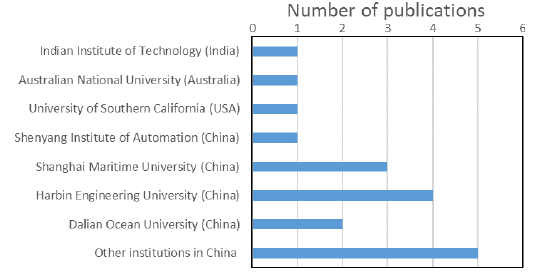
Fig. 7 Number of publications by different research